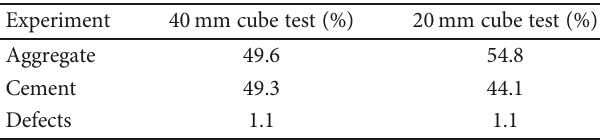
Figure 8: 3D segmentation of the specimen before loading. Table 2: Volume fractions of each phase in segmented 40 mm and 20 mm